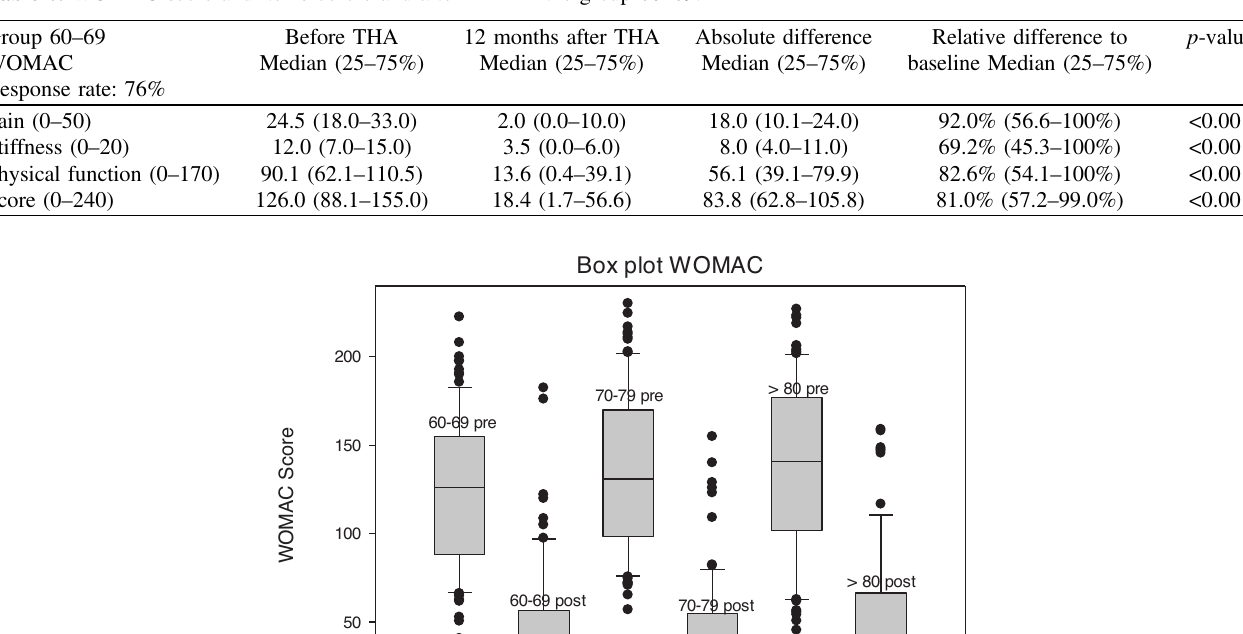
Table 6. WOMAC score and items before and after THA in the group 60 – 69.